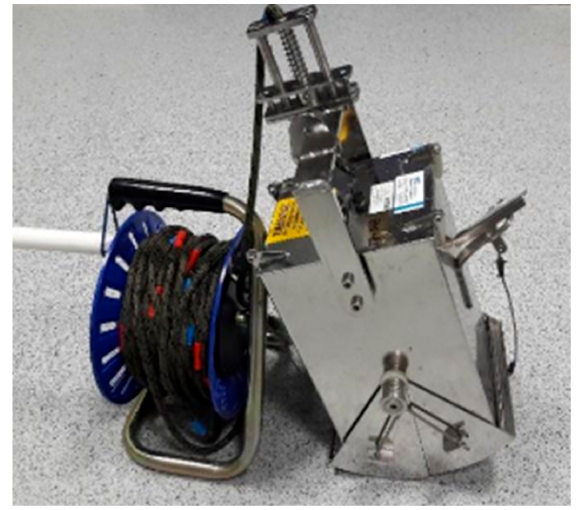
Figure 3. Ekman bottom sediment sampler.